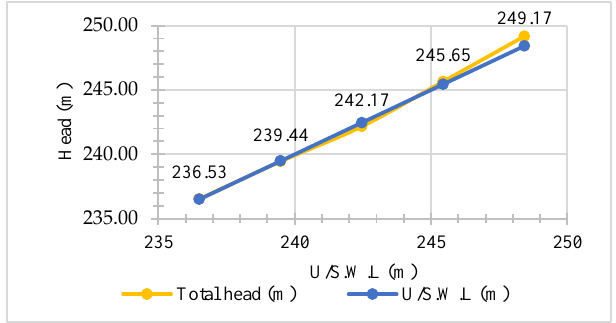
Figure 9. The inlet total head results of the 3D Temenggor turbine model.